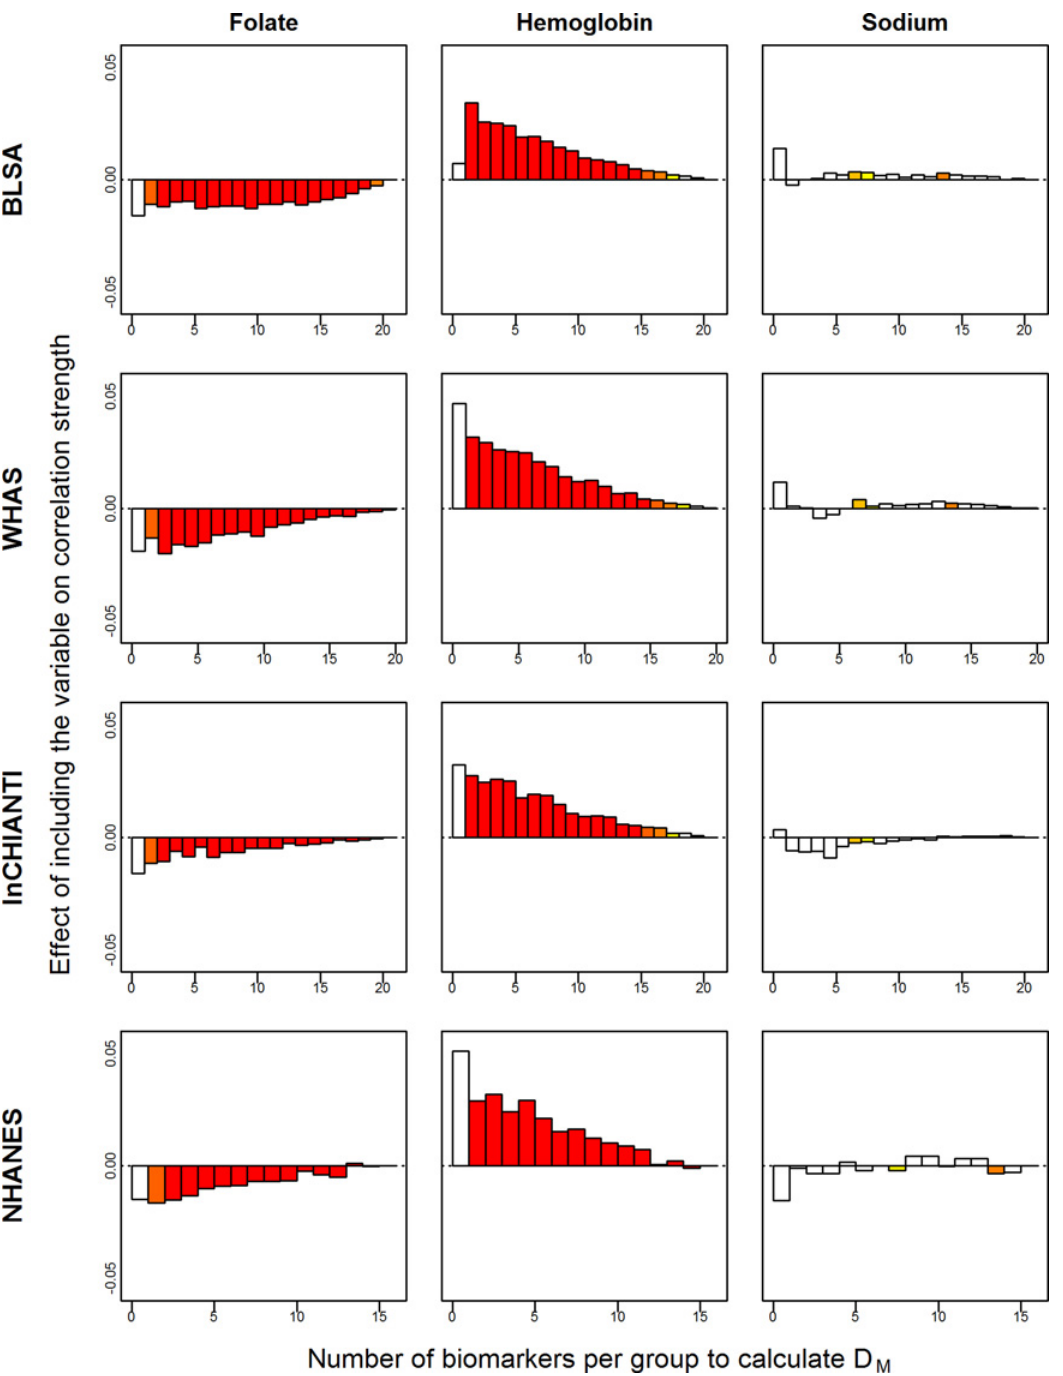
Fig 4. Contribution of selected individual biomarkers to pairwise D M correlations, as a function of biomarker number. The X-axis represents the number of biomarkers per group ( N bm ) and the Y-axis reports the coefficient ( β ) from a linear regression of the D M pairwise correlations on N bm . β s represent the deviation from the average correlation when a given biomarker is included in the calculation of D M ; positive values thus indicate improved performance of p -values, with darker red being more significant and white not significant. D M , and negative values decreased performance. Colors indicate the magnitude of Graphs for all biomarkers can be found in S8 – S11